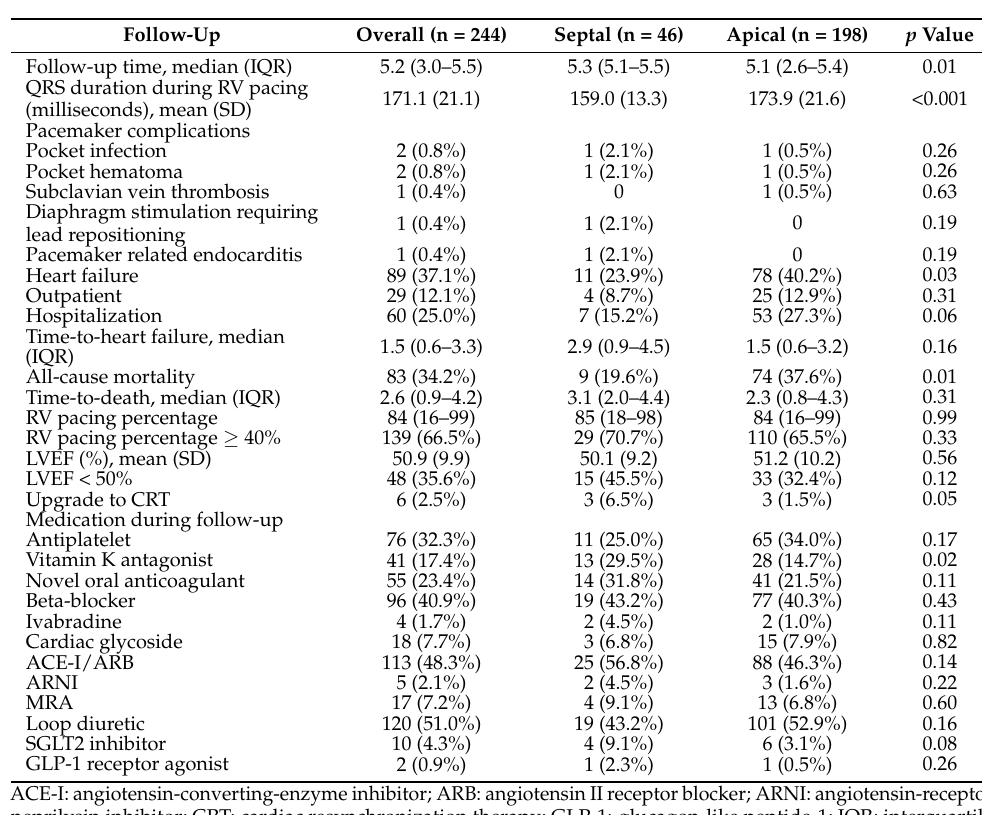
Figure 2. Heart failure during follow-up in patients with septal and apical right ventricular pacing lead.